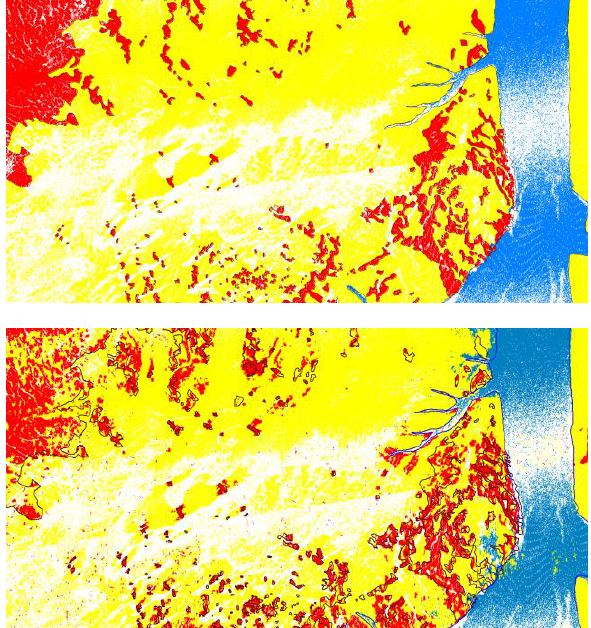
Figure 7. Reference data (top) and classified point cloud (bottom) with the classes water (blue), mudflat (yellow) and mussel bed (red). Areas with no return are coloured in white.